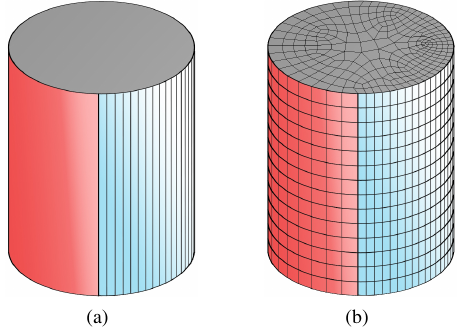
Figure 9. Difference between using an analytical surface (red) and a surface approximated with thin polygons (blue).